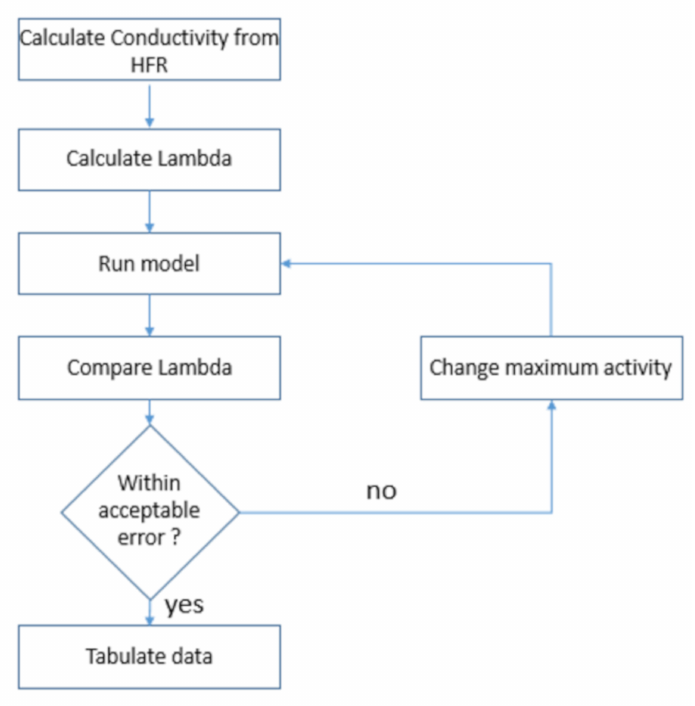
Figure 1. Model development methodology flow chart.